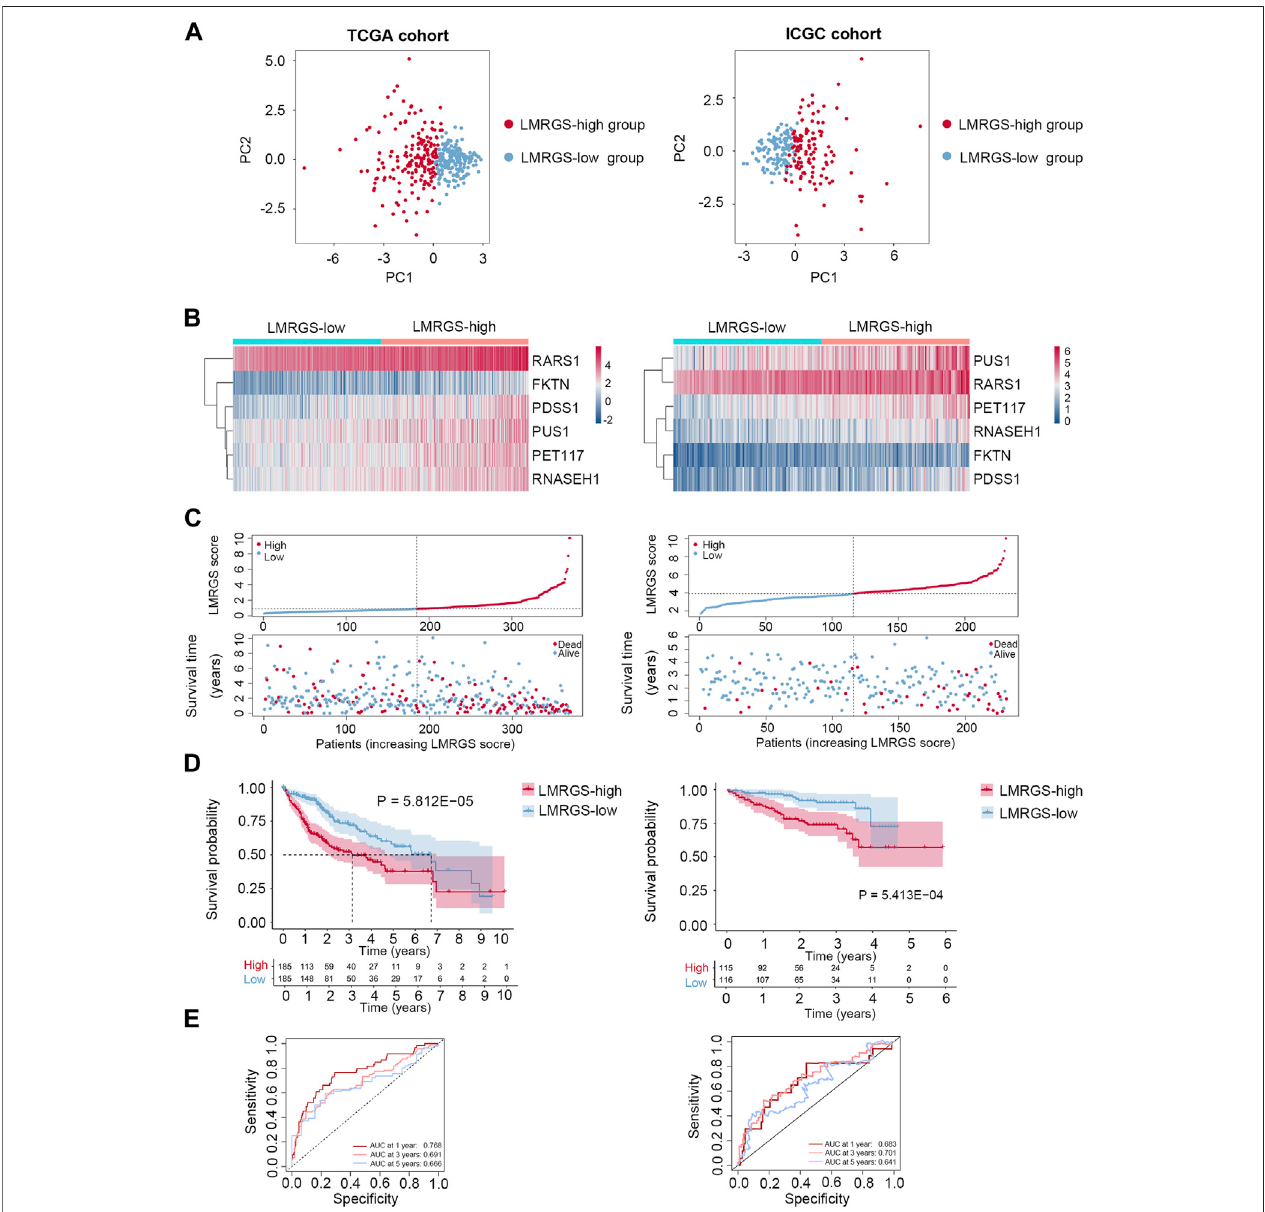
FIGURE3| PrognosticvalueofLMRGSinHCC. (A) PCAwasusedtodeterminewhetherthesamplescouldbegroupedcorrectlybasedontheLMRGSscore. (B) Heatmapfortheexpression ofsixcrucial genesinLMRGS-lowandLMRGS-highgroups. (C) ThedistributionofLMRGS scoresandsurvivalstatus ofHCC patients with increasing LMRGS score. (D) KM survival analysis between LMRGS-low and LMRGS-high groups. (E) ROC curves analysis of LMRGS on OS at 1 year, 3 years, and 5 years.